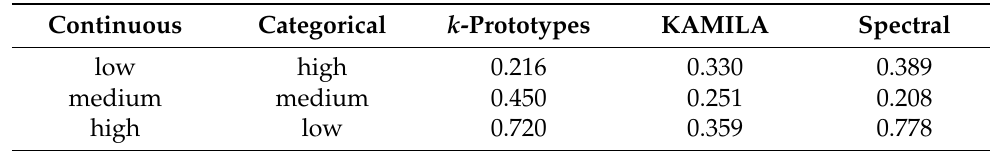
Table 6. Median ARI for different levels of overlap in continuous and categorical variables, n = 10 four-cluster data sets with convex clusters for continuous variables. Continuous Categorical